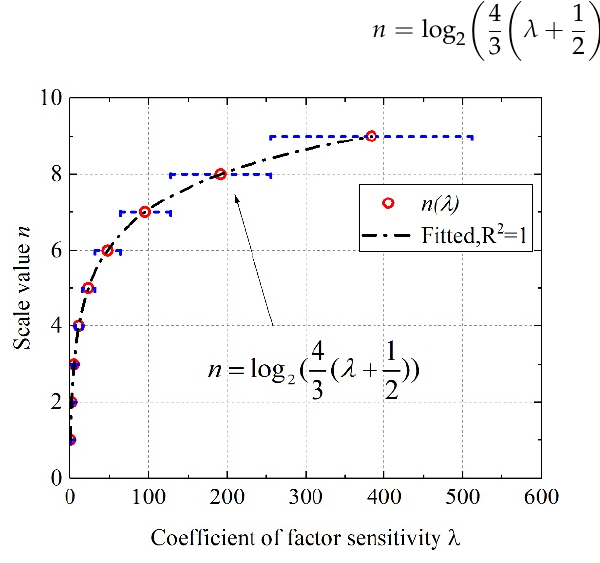
Figure 12. Curve of factor sensitivity coefficient and scale value. Table 4. Conversion between and coefficient of factor sensitivity and scale value.